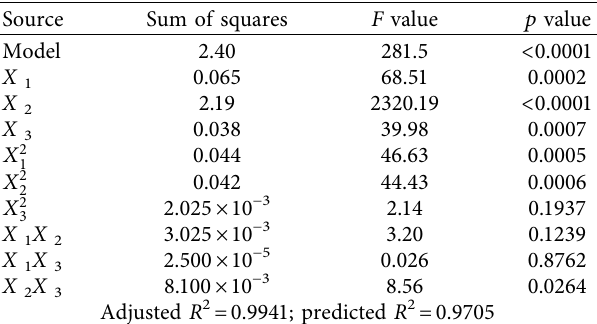
Table 7: Analysis of variance for regression models of unconfned compressive strength.